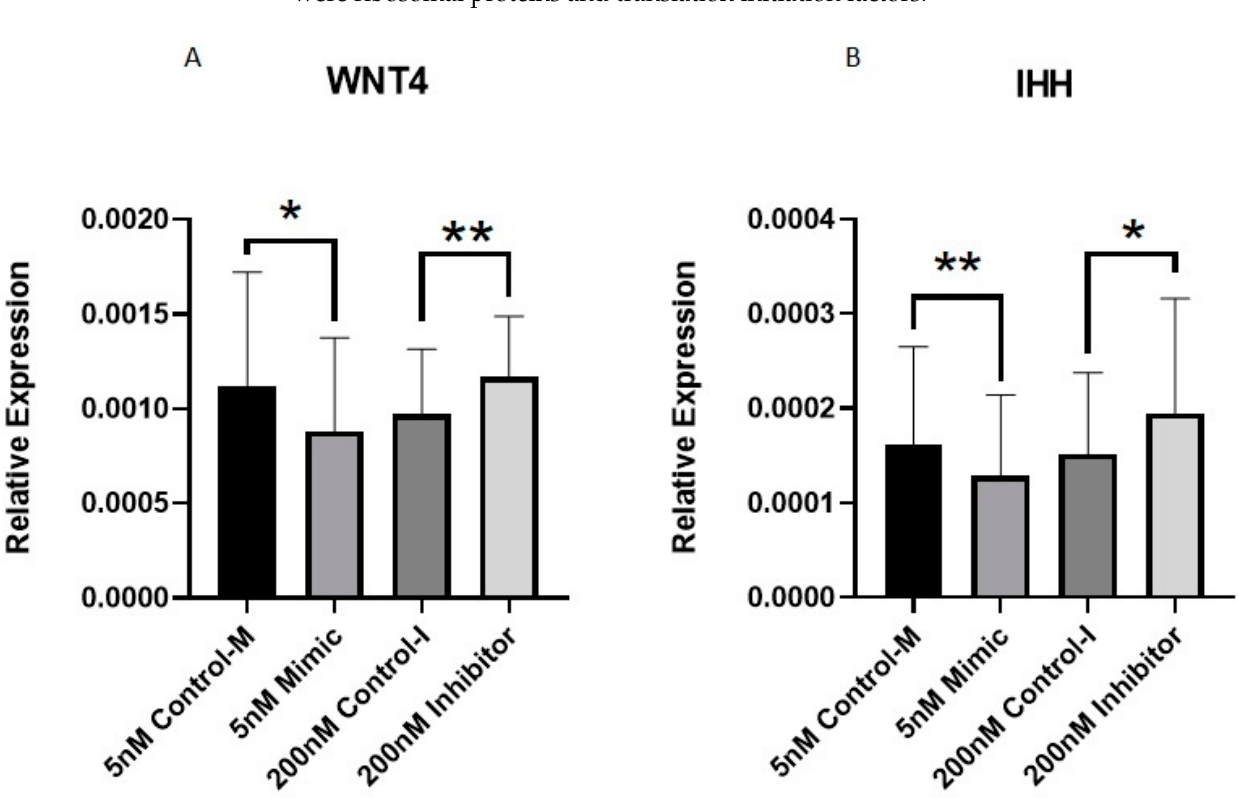
Figure 7. Expression of WNT4 and IHH in human primary OA chondrocytes treated with miR-107 mimic, inhibitor or control. Human OA chondrocytes were treated in media supplemented with 10 ng/mL IL-1 β with 5 nM miR-107 mimic, 200 nM miR-107 inhibitor or control for 48 h. Expression of ( A ) WNT4 and ( B ) IHH are shown ( n = 8–11 donors). Expression is relative to GAPDH . Statistical analysis was undertaken using a two-tailed paired t-test in GraphPad Prism (Version 8.0.1). Data are represented as mean + SD. p values < 0.05 were considered significant. *: p < 0.05, **: p < 0.01. Control m = control-mimic, control-I = control-inhibitor.